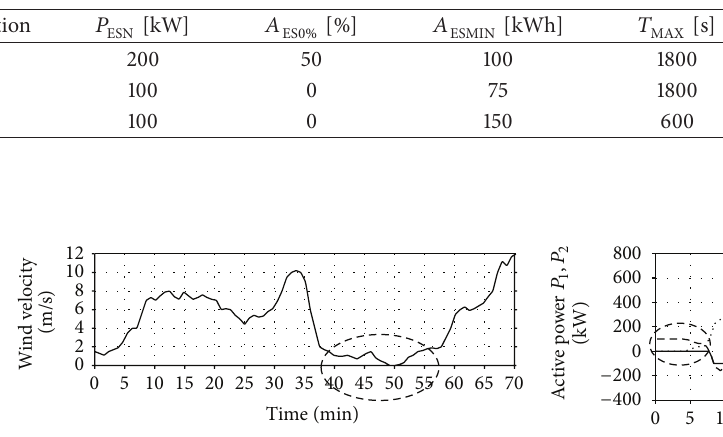
Table 4: List of technical parameters of WT-FESS used in simulation tests.